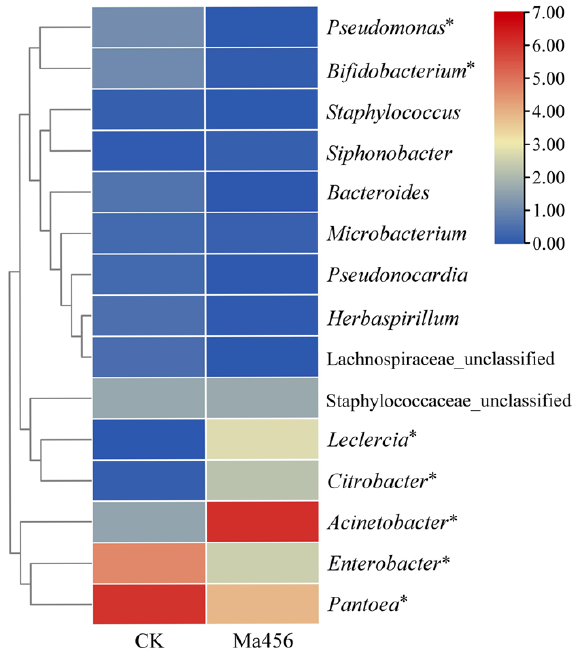
Figure 4. Heatmap of the relative abundance of the top 15 predominant bacterial genera in the gut of BPH that were treated by fungal infection (Ma456) and 0.02% Tween 80 (CK). The color scale represents values of relative abundances (%) normalized by log 2 . Zero values were added as 1 and log 2 transformed. Asterisked species differ significantly in the relative abundance between two BPH gut samples ( p <